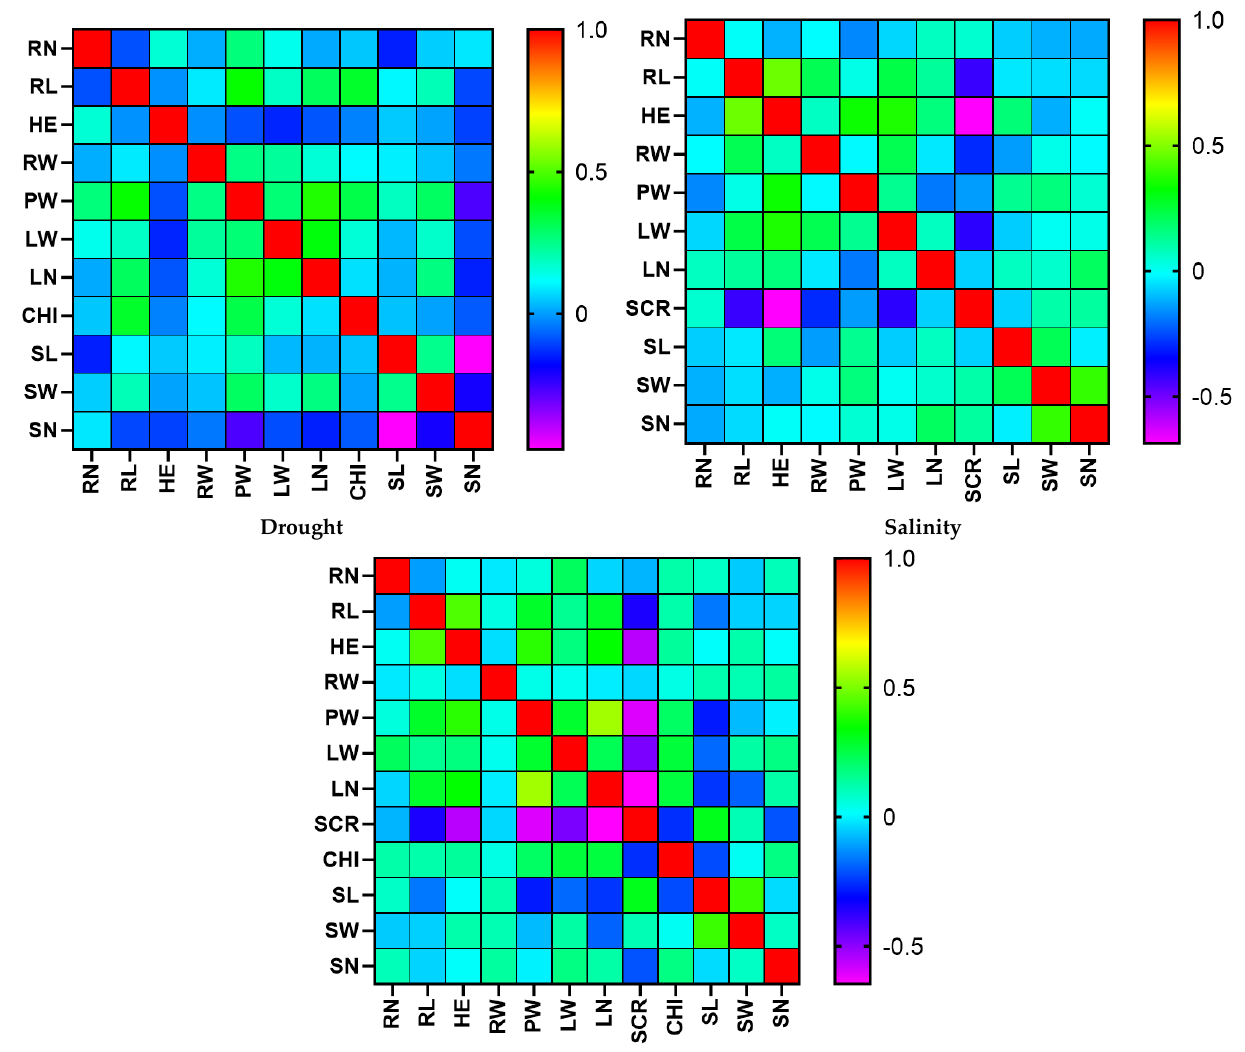
Figure 1. Correlation diagram of the physiological and morphological traits under salinity, drought, and normal stress in the seedling stage of the RIL population caused by the Kavir and Badia cross. The red to yellow color spectrum indicates a correlation between 1 and 0.5. Next, the green color spectrum indicates a correlation between 0.5 and 0. The light blue spectrum indicates a correlation between 0 and − 0.5. Finally, the dark blue to navy blue color spectrum indicates a correlation be ‐ tween − 0.5 and − 1.